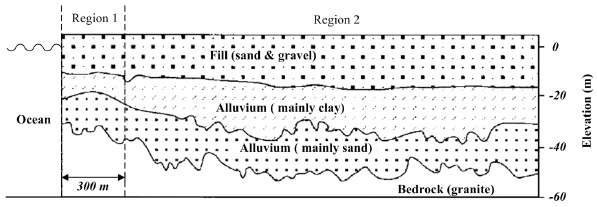
Figure 8. A geological cross section in the CLK Airport, Hong Kong (modified from Jiao and Tang, 1999).